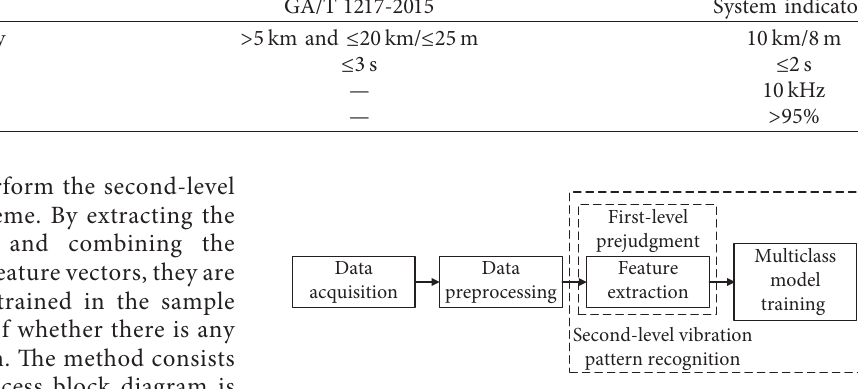
Figure 3: Functional diagram of the fiber vibration mode recognition.